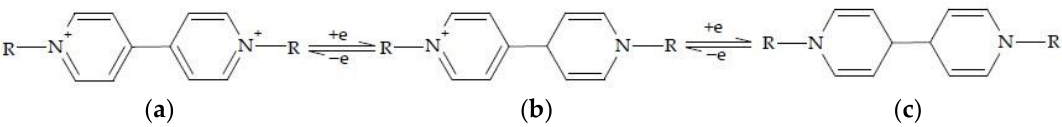
Figure 7. Three general viologen redox states (in terms of electron transfer): ( a ) dication; ( b ) radical cation; ( c ) neutral state. Viologens are used in RGB (red, green, blue) devices (Figure 8), which reproduce three main colors, red, green and blue, although research in this area is not yet well developed. Modern technologies require the use of multicolor EC, which, in turn, necessitates the creation of new functional composites